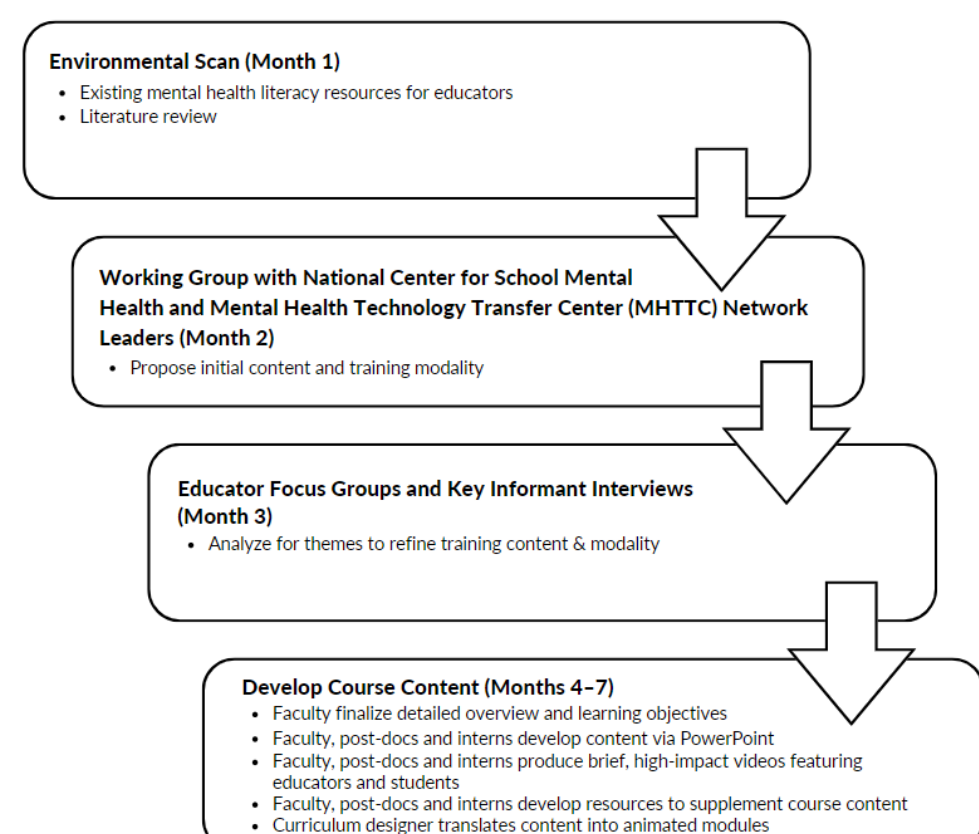
Figure 1. Curriculum development process.